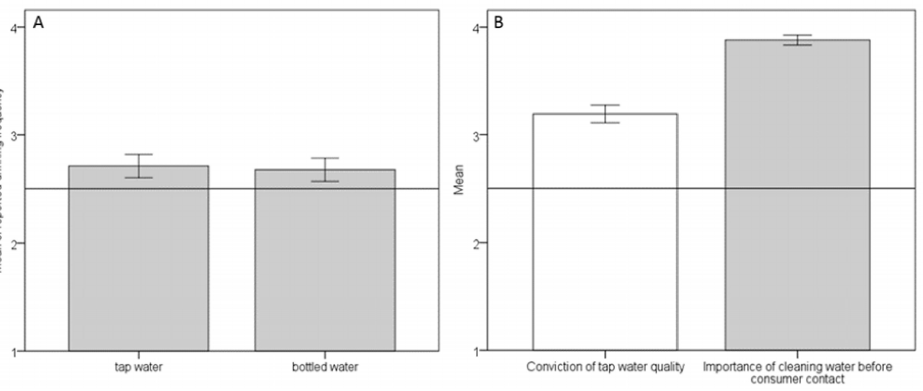
Figure 1. ( A ) Q1 and Q2: “How often do you drink” Q1) “ . . . tap water?” Q2) “ . . . bottled water?” ( B ) Q5: “I am convinced of the quality of my tap-water” and Q6: “How important do you rate the cleaning of water before it is passed to the consumer?” Line represents the mean of rating options (2.5). Error bars (95% CI).